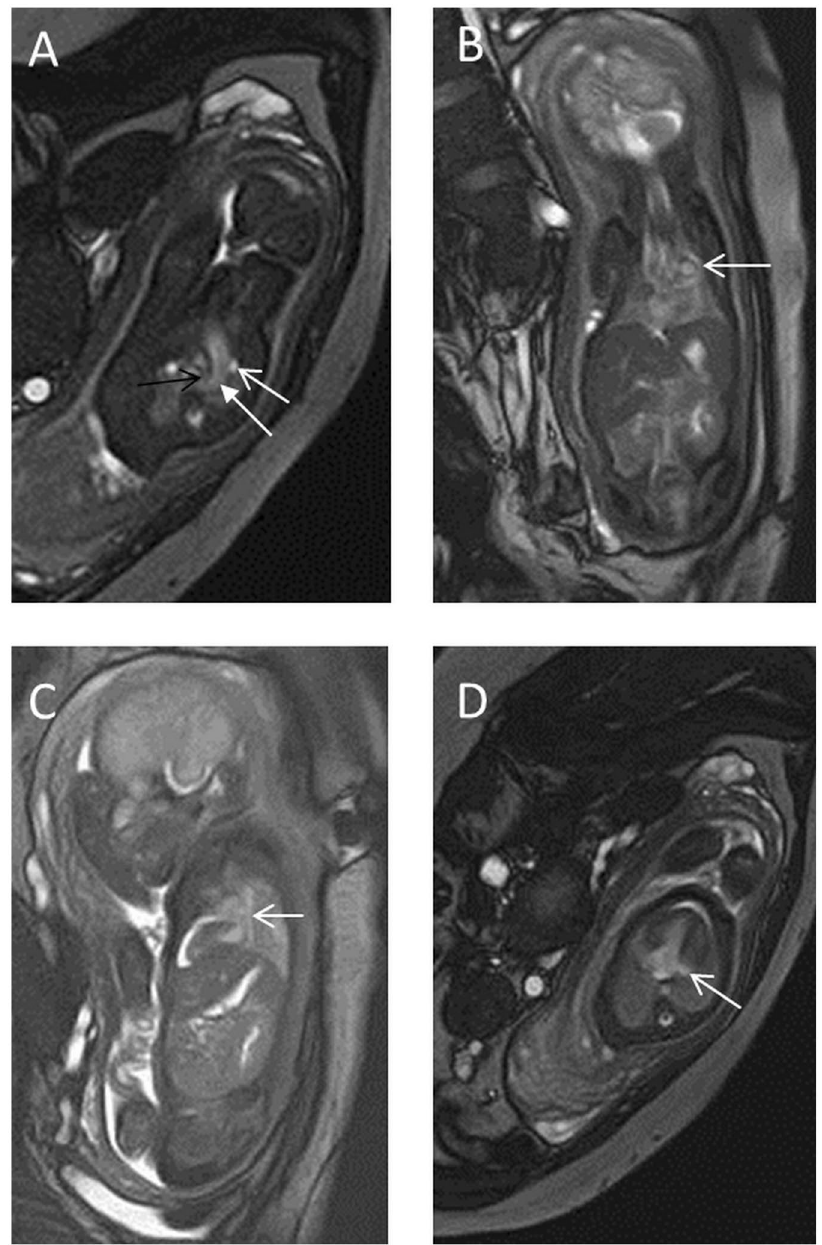
Figure 3. A 32-week fetus with coarctation of the aorta and persistent LSVC. Fetal CMR B-TFE transverse view of the aortic arch and coronal and oblique sagittal views show persistent LSVC (white open arrows in A,B and C ), CoA (black open arrow in A ) and a large ductus arteriosus arch (arrow in A) ; four-chamber views show an enlarged coronary sinus (open arrow in D